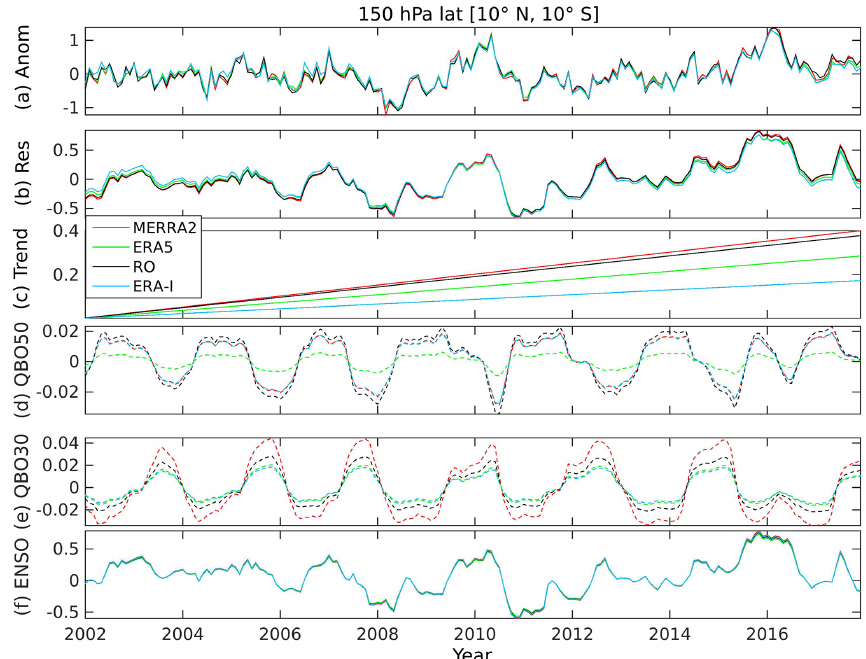
Figure 6. Temperature anomaly at 150hPa in the tropics (10 ◦ S–10 ◦ N) from ERA5 (green), ERA-I (light blue), MERRA2 (red) and GNSS RO (black) (a) . (b) The corresponding residual. (c) The linear terms. (d) The QBO50 terms. (e) The QBO30 terms and (f) the ENSO terms. The solid lines in (c–f) mark the significant terms and the dashed lines in (c–f) mark the insignificant terms.